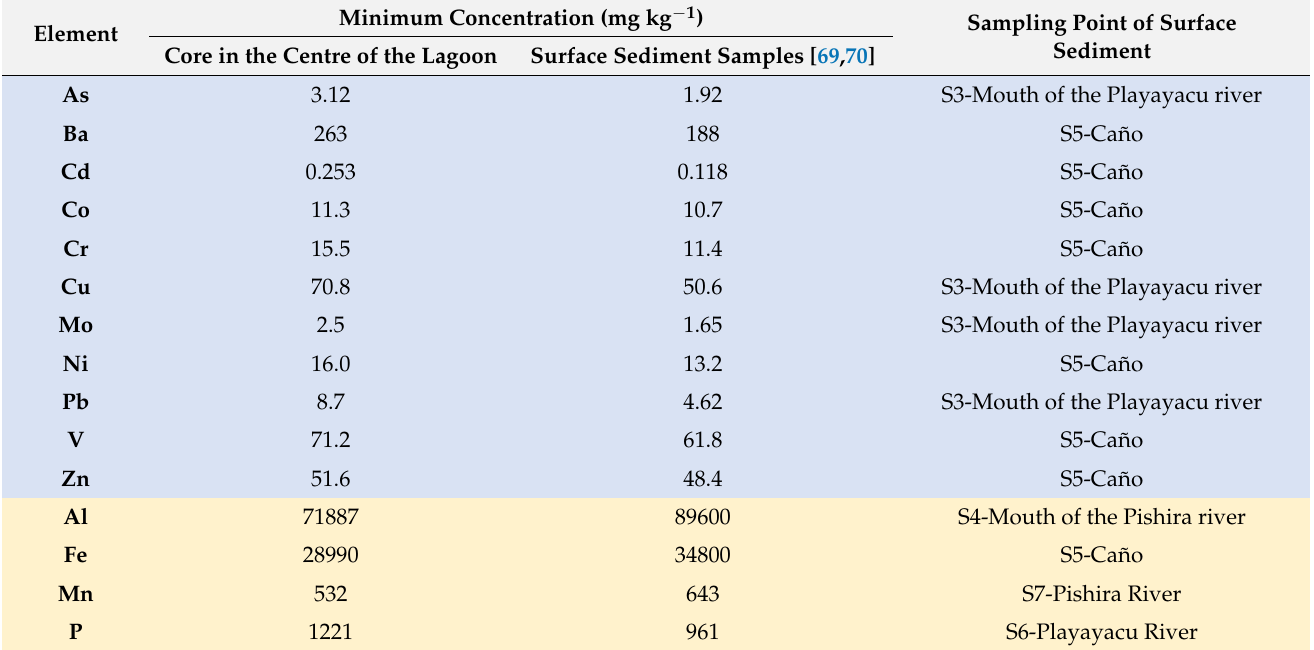
Table 2. Minimum concentrations of minor and major analyzed elements in the sediment core of the center of the lagoon in comparison to surface sediment